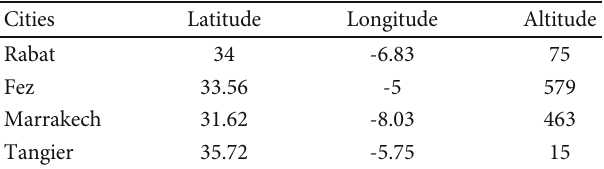
Table 1: Measuring station locations